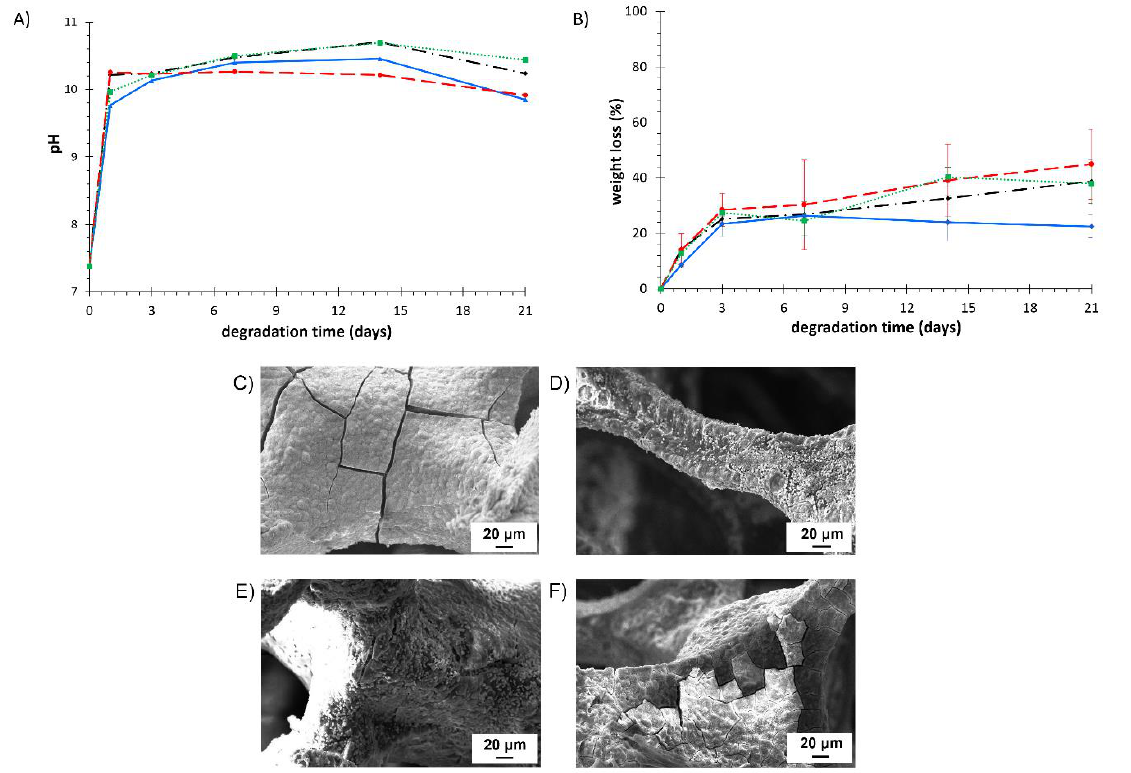
Figure 10. ( A ) pH variation of the PBS containing pure BG (black, dashed-dotted line), PCL/BG (green, dotted line), KHC2000/BG (blue, continuous line), KHC2000E2000/BG (red, dashed line) scaffolds during hydrolytic degradation tests. ( B ) Weight loss profile of pure BG (black, dashed- dotted line), PCL/BG (green, dotted line), KHC2000/BG (blue, continuous line), KHC2000E2000/BG (red, dashed line) scaffolds during hydrolytic degradation in PBS. SEM micrographs of ( C ) BG, ( D ) PCL/BG, ( E ) KHC2000/BG and ( F ) KHC2000E2000/BG scaffolds after 21 days immersion in PBS.